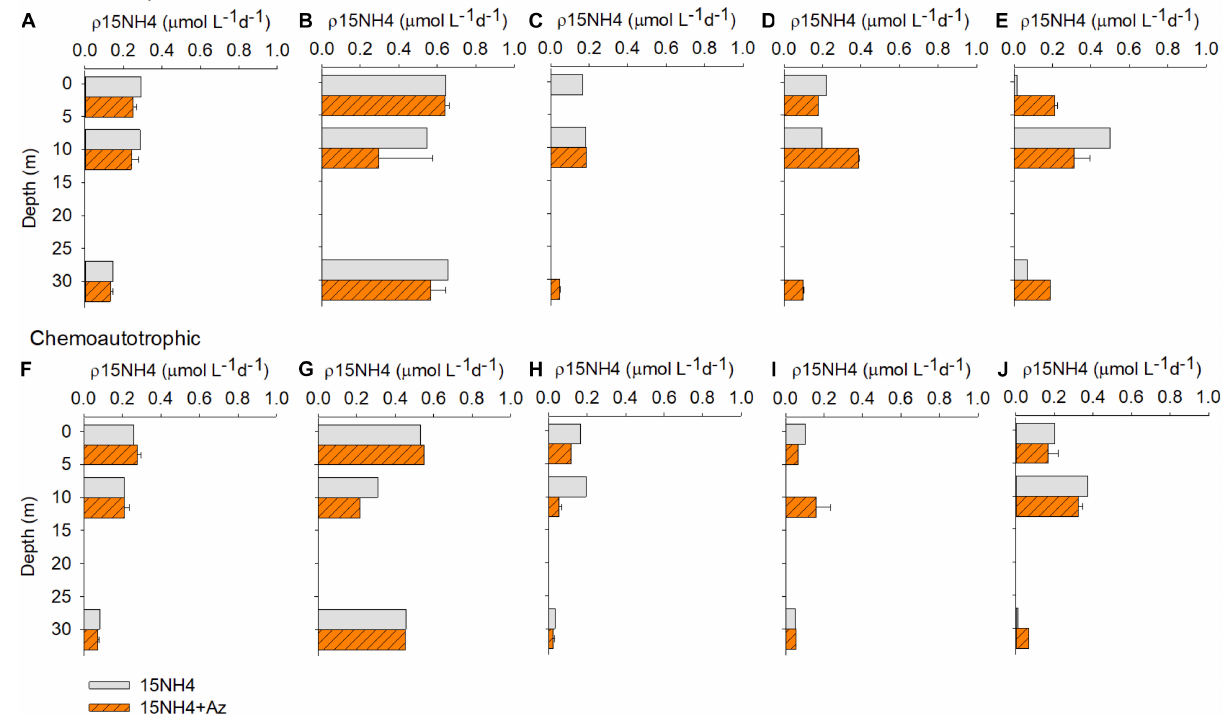
control ( Figure 6J ). But, these effects were not significant (paired t -test >